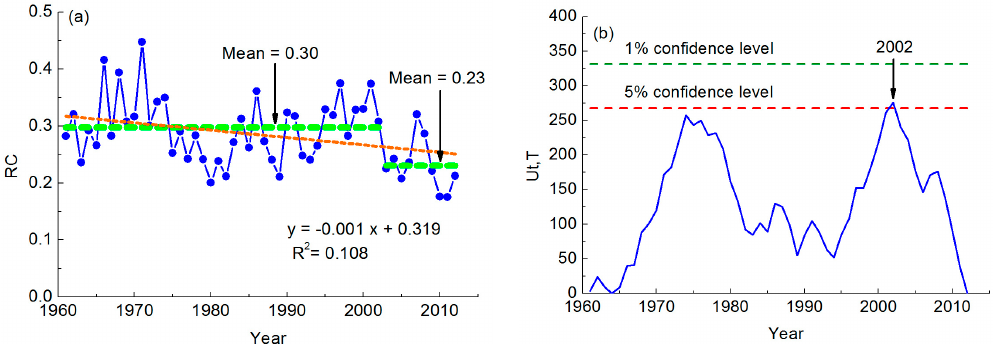
Figure 4. The variation of annual runoff coefficient series ( a ) and change point test of annual runoff coefficient series ( b ) in the URRB during 1961–2012.